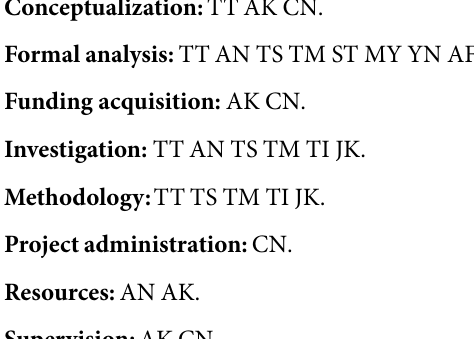
S4 Fig. Detection of segments S1 of PRV-2, PRV genotype I, and PRV genotype II from cDNA samples prepared from the purified virus and EIBS-affectedcoho salmon. A) Nucle- otide sequence alignment of the genomic segment S1 of PRV-2, consensus sequence of segment S1 of PRV genotype I, and consensus sequence of segment S1 of PRV genotype II is shown. Consensus sequence of segment S1 of PRV genotype I, including subgenotype Ia and subgeno- type Ib, was generated from sequences determined in a previous study (GenBank accession nos GU994022, HG329848, HG329868, HG329897, JN991006, KC473453, KC473454, KC795571, KR872636, KT456500, KT456501, KT456503, KT456505, KU131591, KU131593, KU131594, KU131597, KU131598, KU131602, KU131603, KU131604, KU160513, and KU160514) [19]. Consensus sequence of segment S1 of PRV genotype II was generated from GenBank accession nos KU131595, KU131596, and LN680851. Regions rich in polymorphisms (1F, 2F, 1R, and 2R) were selected and specific PCR primers designed to them. Identical nucleotides in the aligned sequences are indicated with solid boxes. Arrows indicate the directions of primers. PCR primer pairs targeting 1F and 1R amplified 312-bp fragments. PCR primer pairs targeting 2F and 2R amplified 333-bp fragments. B) Detection of genomic segment S1 in cDNA samples of (i) purified virus, (ii) blood of naïve coho salmon (n = 5), (iii) blood of artificially infected coho salmon at 28 dpi (n = 5), and (iv) kidney of EIBS-affectedcoho salmon from the inland farm at week 2 (n = 5). Except in the naïve fish, PCR amplicons were detected with the specific primer pairs for PRV-2, whereas no bands were detected with the specific primer pairs for PRV genotype I (Gt I) or Gt II. Molecular size marker (M) indicates 0.5 kbp (upper band) and 0.1 kbp (lower band). S1 Table. List of accession numbers of proteins from representative virusesin the subfamily Spinareovirinae used in this